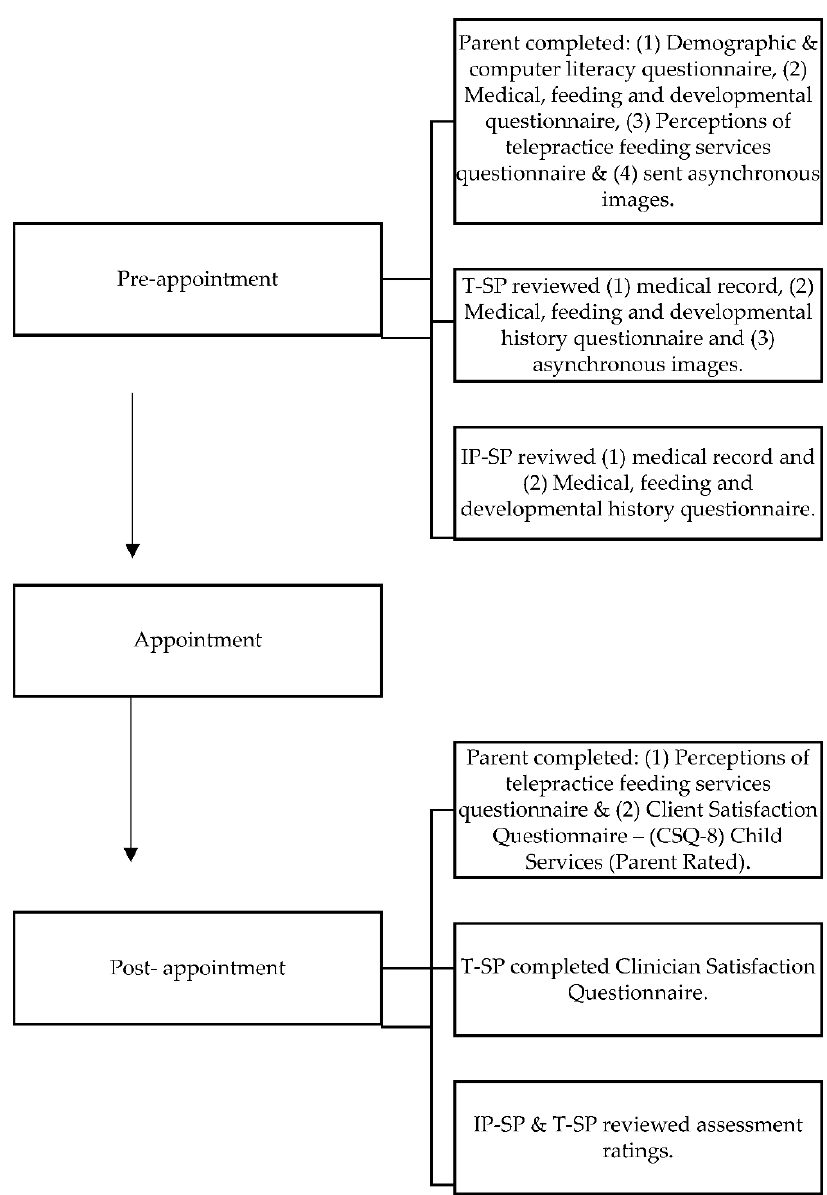
Figure 1. Overview of telepractice appointment procedures .